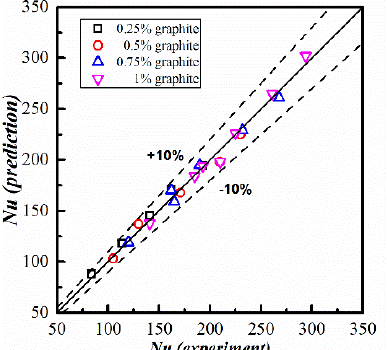
Figure 5. Comparison of Nu between the experiments and the predictions from the regression equation.